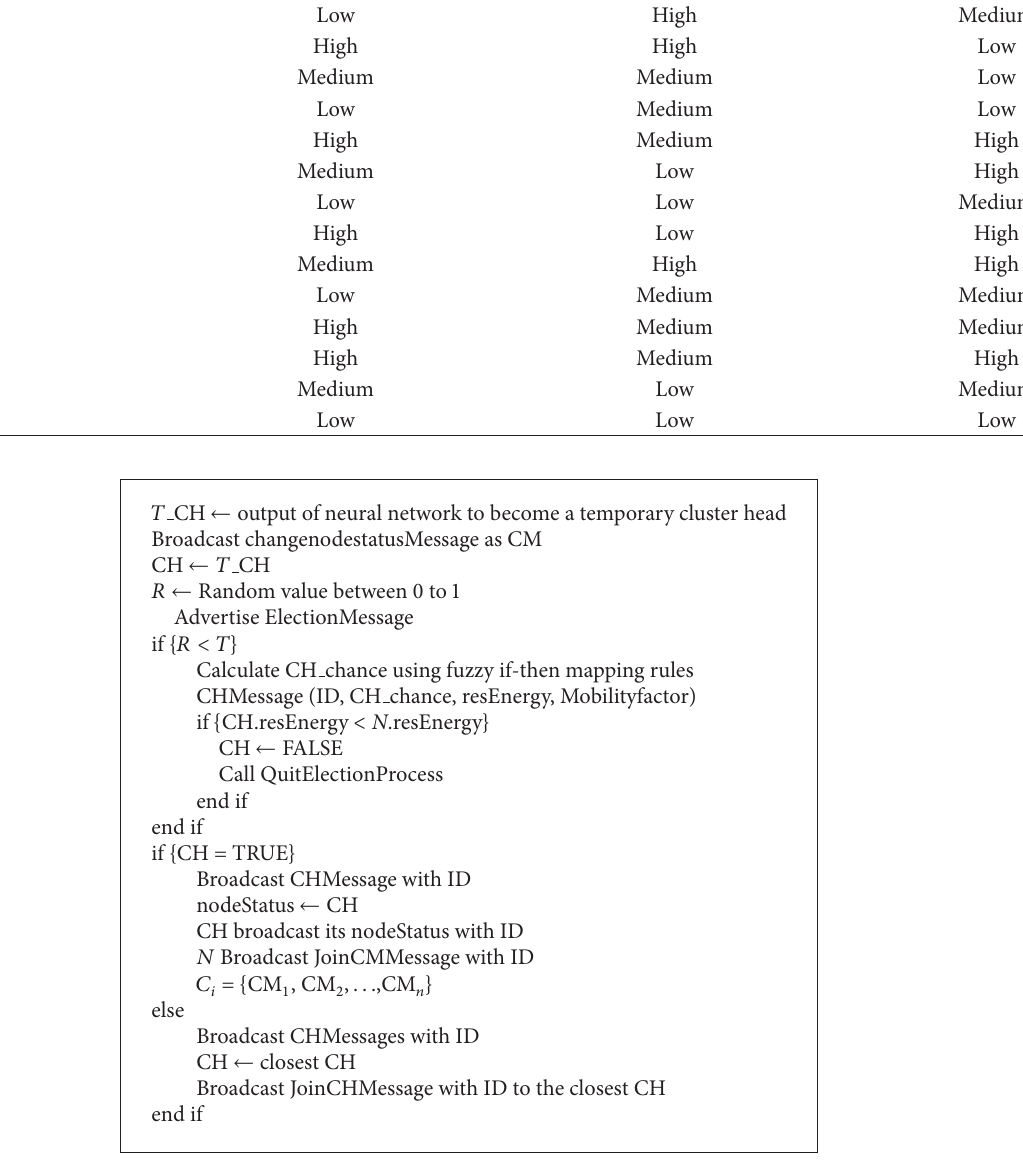
Algorithm 2: Clustering algorithm of NFEACS